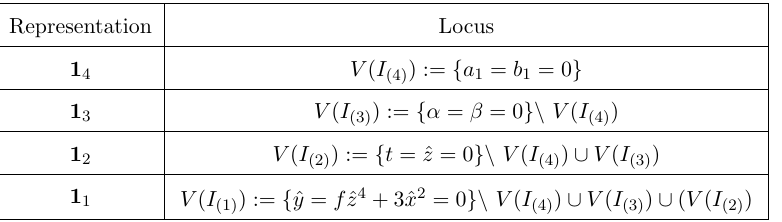
Table 6 . The loci for the charged matter representations under the U(1) symmetry for the charge 4 model. The charges are written as subscripts. The locus for the state 1 1 is given in terms of the sections ^ x , ^ y and ^ z that are the coordinates for the additional section discussed in appendix